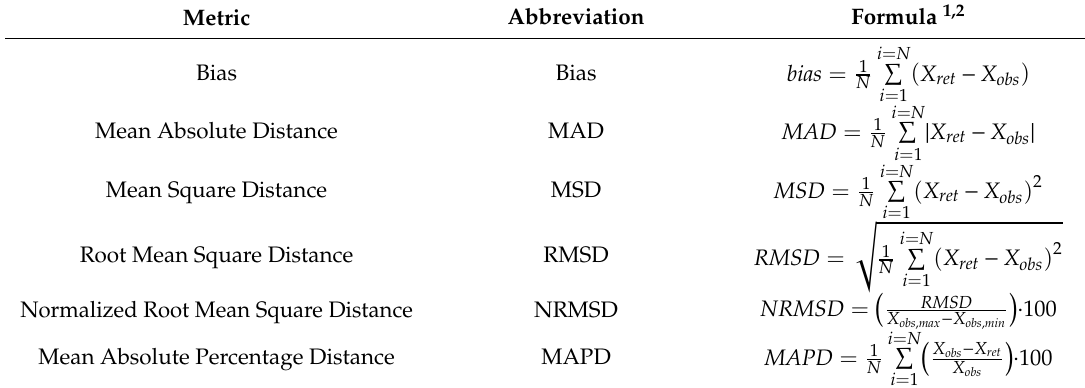
Table 1. List of error